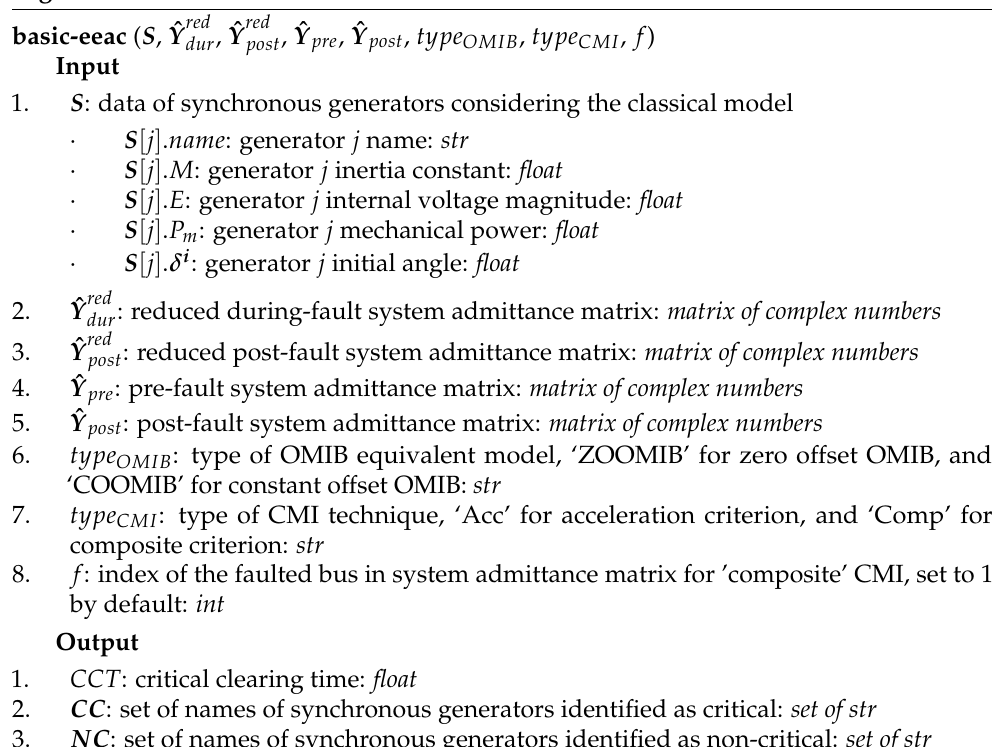
Algorithm A12 Basic scheme for